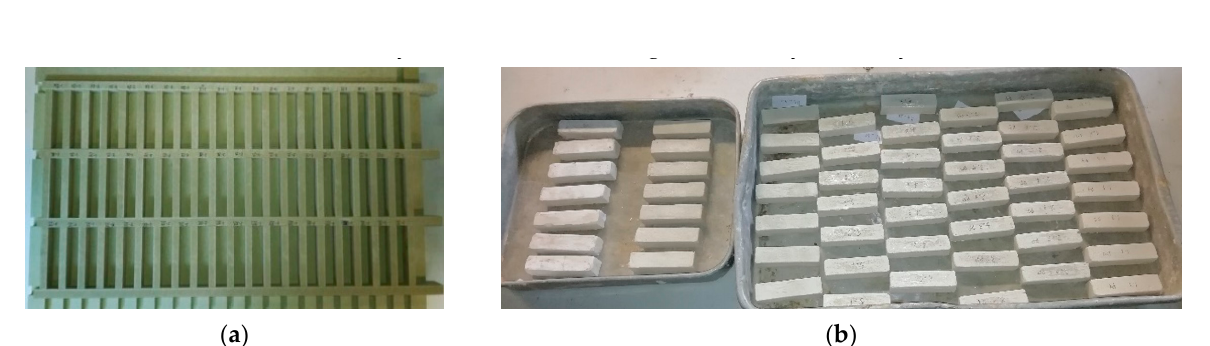
Figure 2. Prismatic specimens: ( a ) Molds for samples with 20 × 20 × 80 mm 3 ; ( b ) Illustration of some specimens after